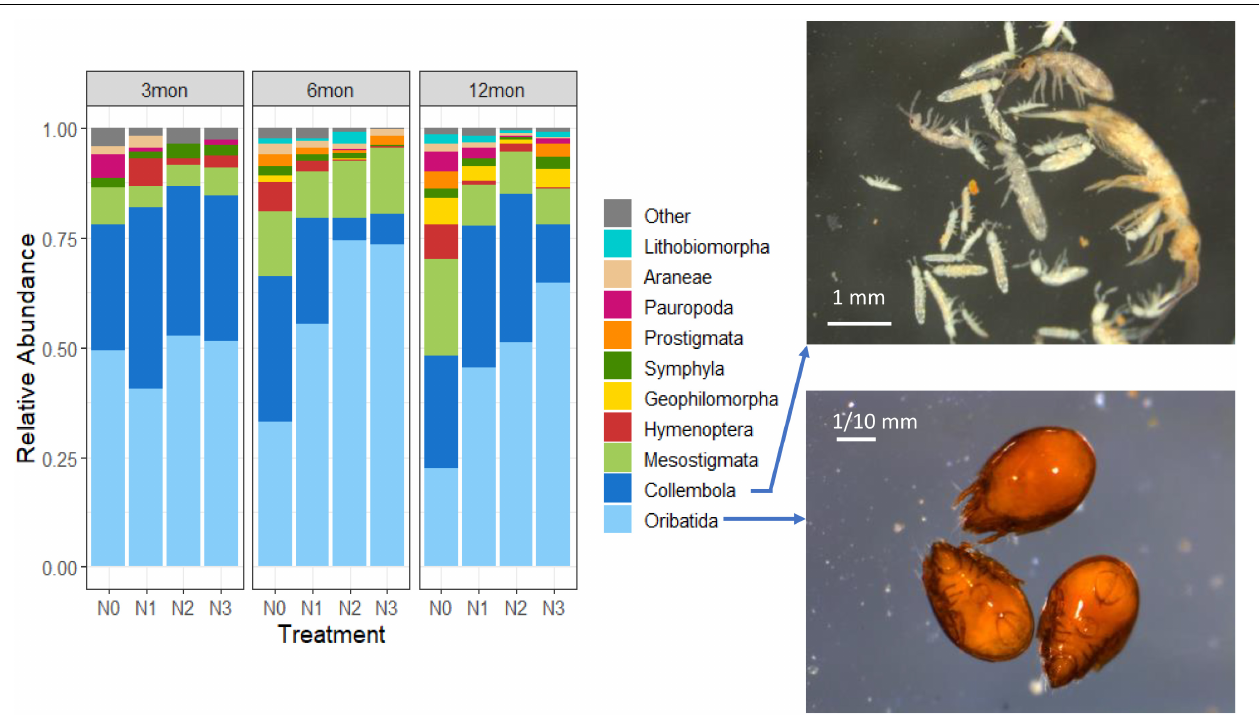
FIGURE 2 | Left: Community composition (0–10 cm) of pedofauna populations associated with the increasing N doses added to the soil in relation to the duration of the treatment. The groups accounting for ≥ 1% are shown with explicit nomenclature, while those < 1% are integrated into “Other.” Right: Examples of Collembola (top panel) and Oribatida (bottom panel) individuals.